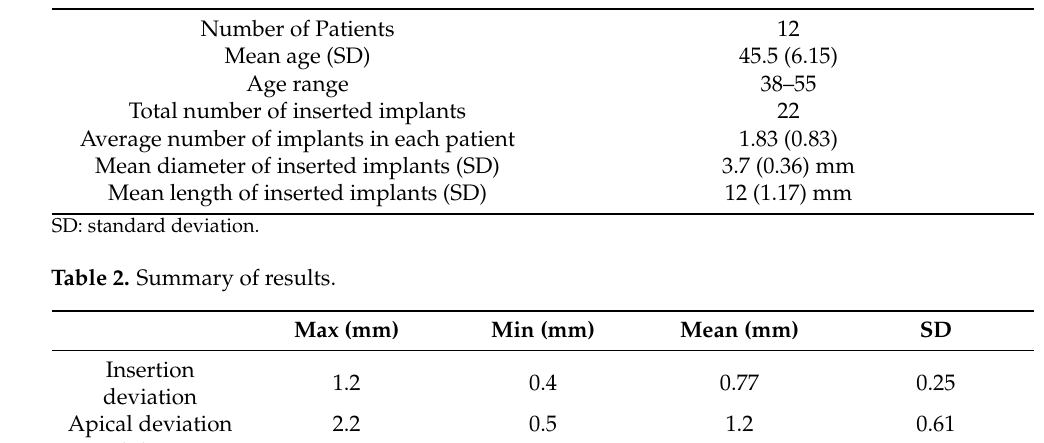
Table 1. Patient and intervention characteristics.